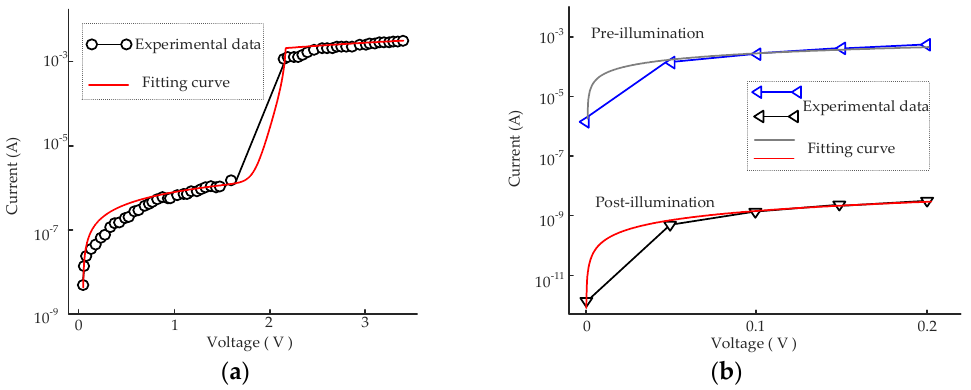
Figure 2. The fitting result of the model showing ( a ) I − V curve of the memristor in the dark environment; and ( b ) I − V curves of the memristor before and after applying illumination.